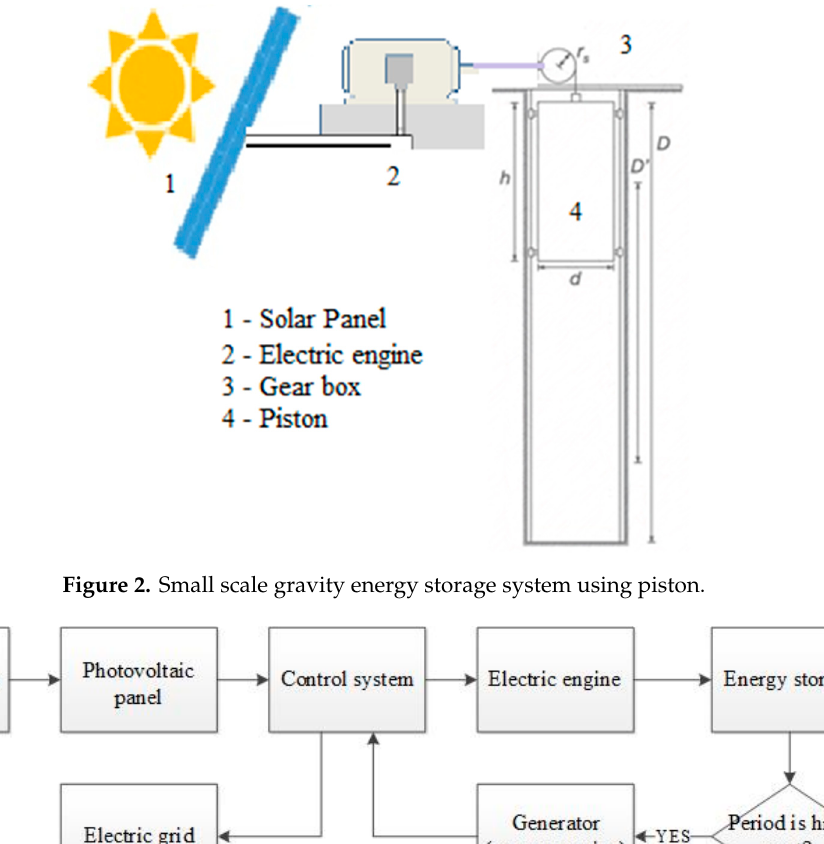
Figure 2. Small scale gravity energy storage system using piston.